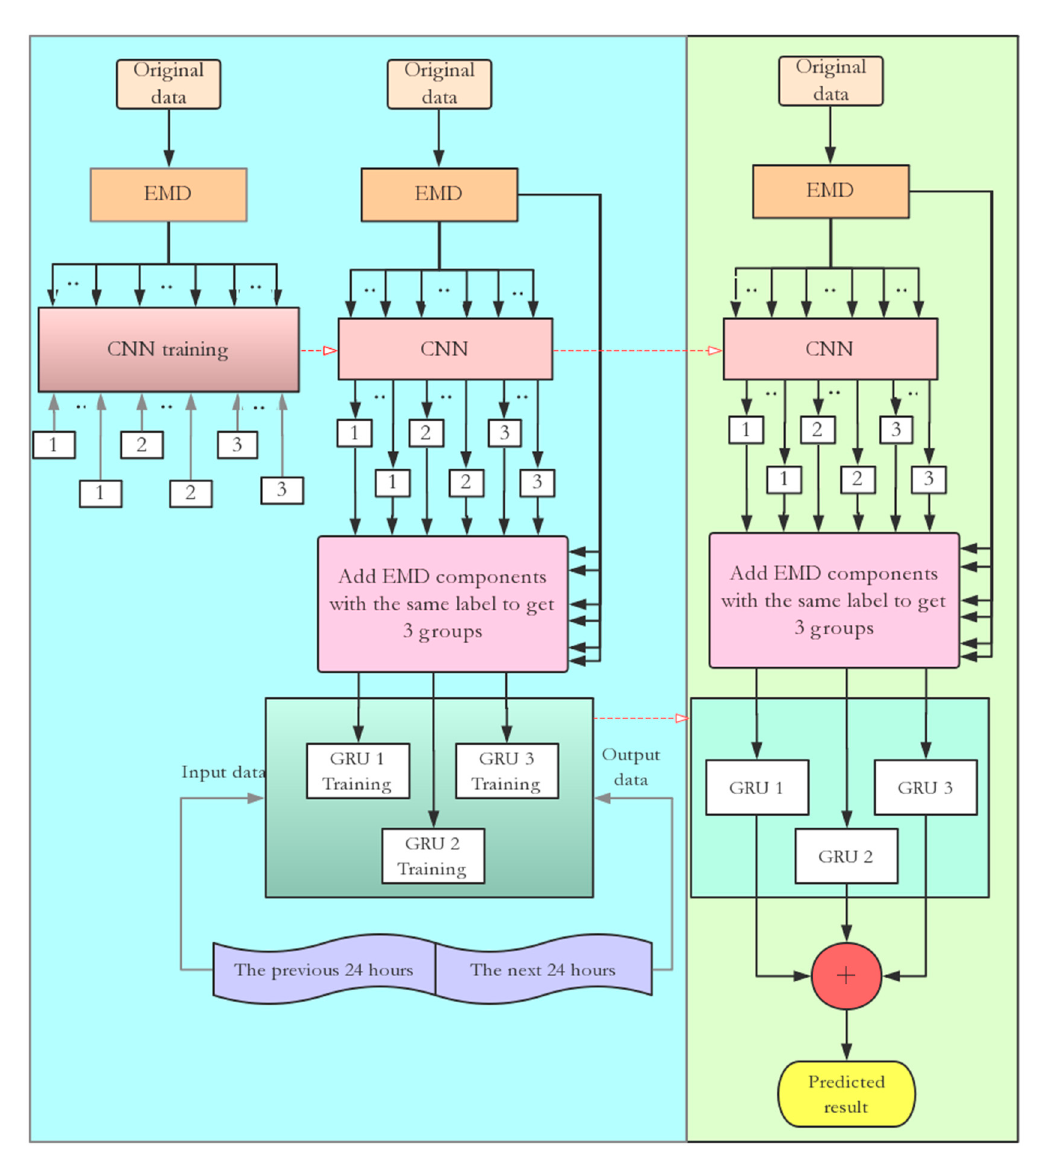
Figure 7. Flowchart of a hybrid predictor for smart agriculture sensing.